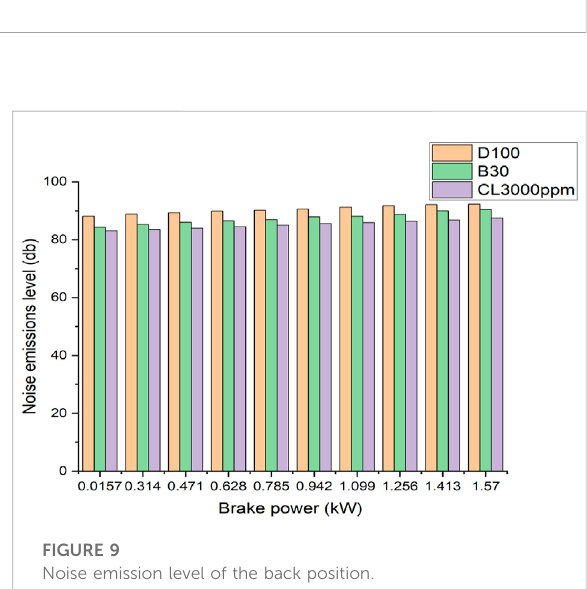
FIGURE 8 Noise emission level of the left position.